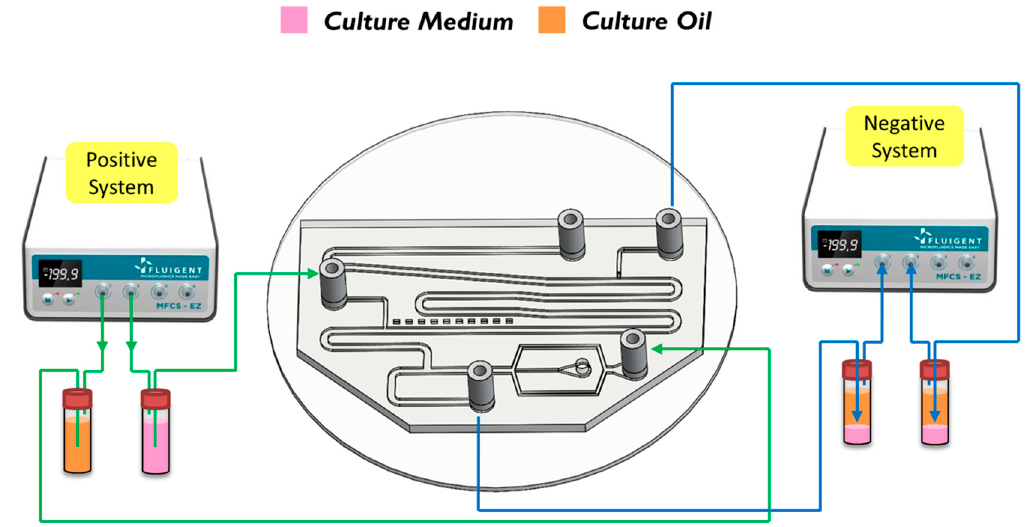
Figure 3. A positve system pushed the oil and the medium into the chip. In contrast, a negative system pulled the waste liquid from the chip.